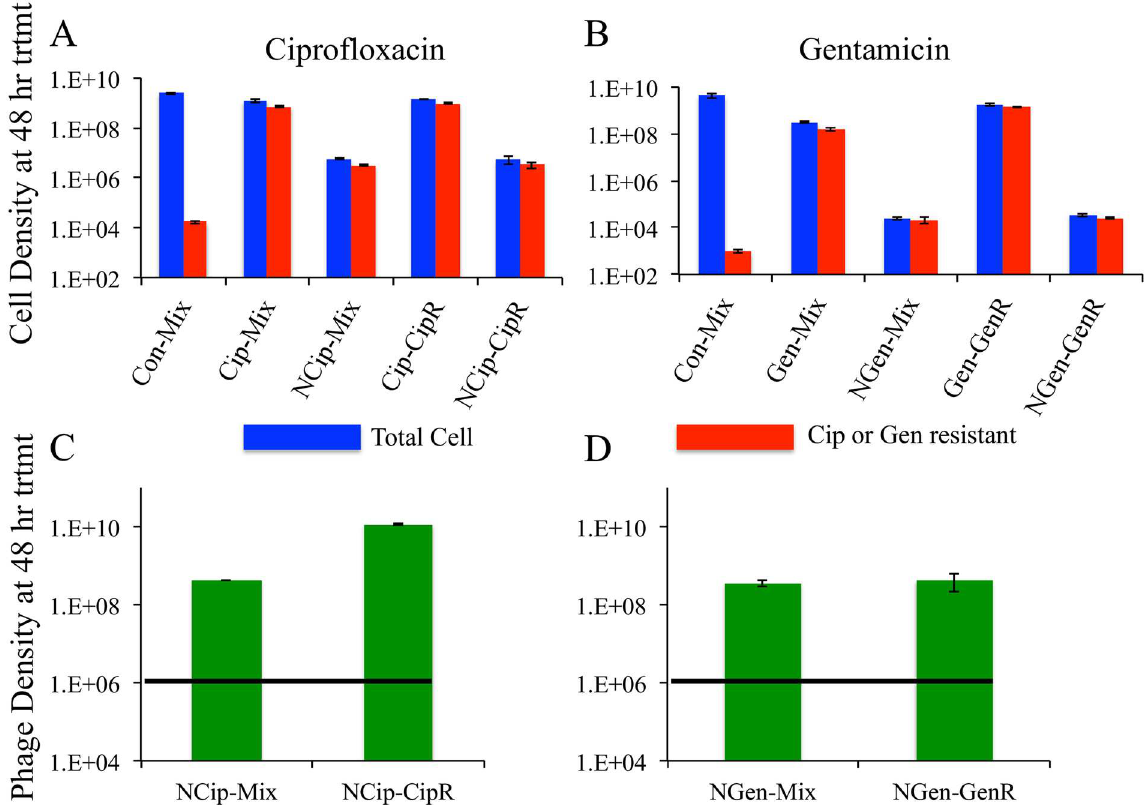
Fig 5. Combination of phage and antibiotic treatment on the ascent of antibiotic resistance. Treatment of P . aeruginosa PA14 biofilm populationsgrown for 48 hours either fully resistant to the treating drug (CipR, GenR) or containing an initial mix of susceptible and drug-resistant bacteria (designated as—Mix). Abbreviations are given by the first 3 letters of the treating drug name followedby the status of the initial population(mixed or fully drug resistant). A prefix N- indicatesinclusionof both phageswith the drug. A- Viable cell density after 48 hours of treatment with ciprofloxacin (Cip) and ciprofloxacin with phage mixture (NCip) B- Viablecell density after 48 hours of treatment with gentamicin(Gen) and gentamicinwith phage mixture (NGen) C- Titers of phage in (A). D- Titers of phage in (B). The horizontal line in (C) and (D) is the initial density of phage.For ciprofloxacin, the differences in total cell density were not statistically significantbetweenCip-Mix and Cip-CipRnor betweenNCip-Mix and NCip-CipR. The difference in the drug resistant fraction betweenCon-Mix and NCip-Mix is highly significant(P << 10 − 4 ). For gentamicin, the differences in total cell density were not statistically significantbetweenNGen-Mix and NGen-GenRbut were statistically significantbetweenGen-Mix and Gen-GenR (P < 10 − 4 ); howeverthe magnitude of difference in this latter case is not large. The difference in the drug resistant fraction between Con-Mixand NGen-Mix is highly significant(P < 10 − 4 ). Raw data of these experiments can be found in (S3 Excel